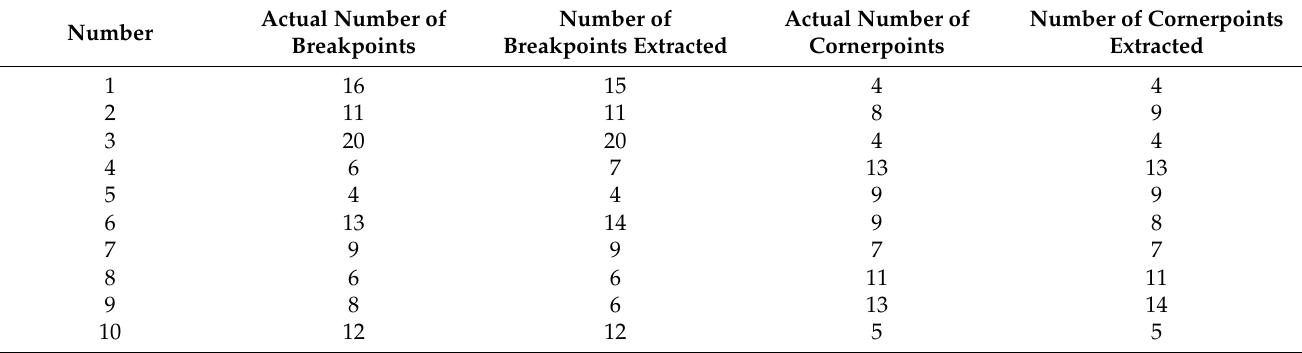
Table 1. Breakpoint and Corner Feature Extraction